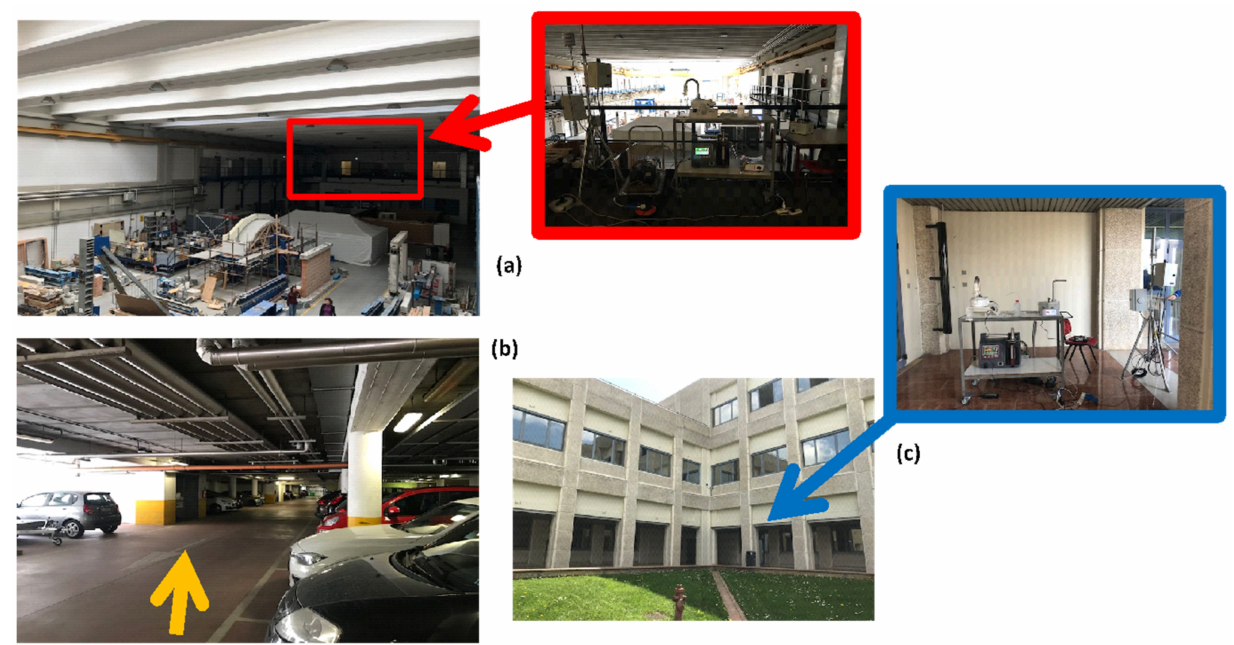
Figure 1. Pictures representing the sampling environments: ( a ) indoor, ( b ) outdoor, and ( c ) garage.